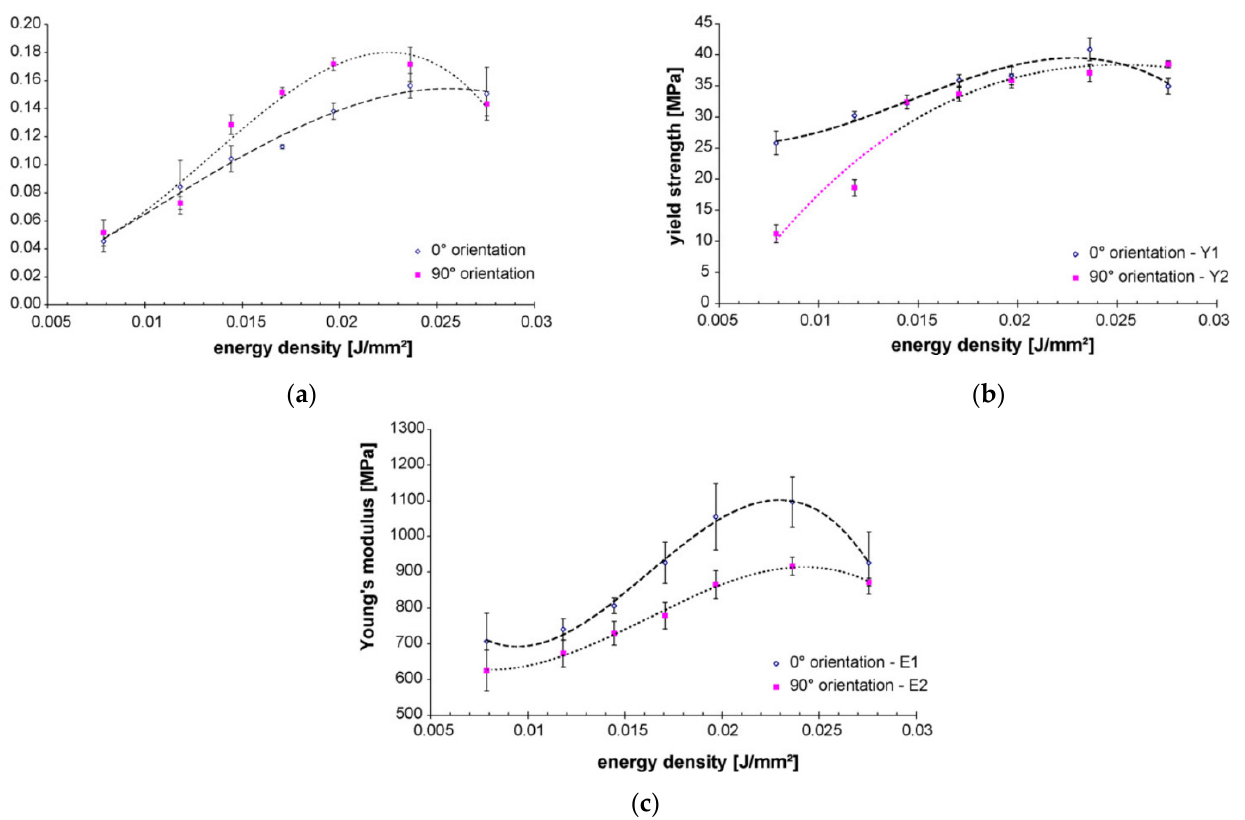
Figure 19. Influence of energy density on ( a ) elongation at break, ( b ) yield strength, and ( c ) Young’s modulus of SLS-sintered PA specimens [146].